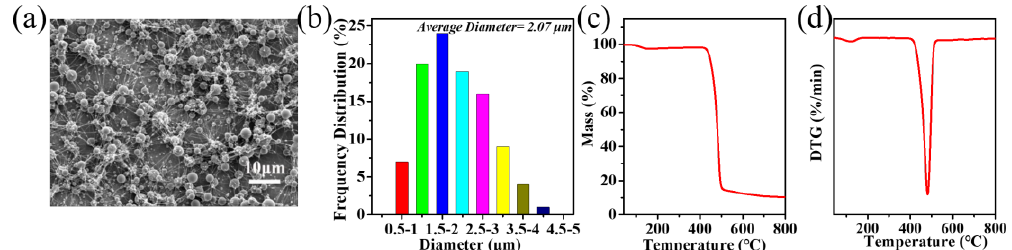
Figure 3. ( a ) SEM micrograph and ( b ) diameter distribution of electrostatic spray PVDF-HFP mi- crospheres, ( c ) TGA and ( d ) DTG curve of FSHM.